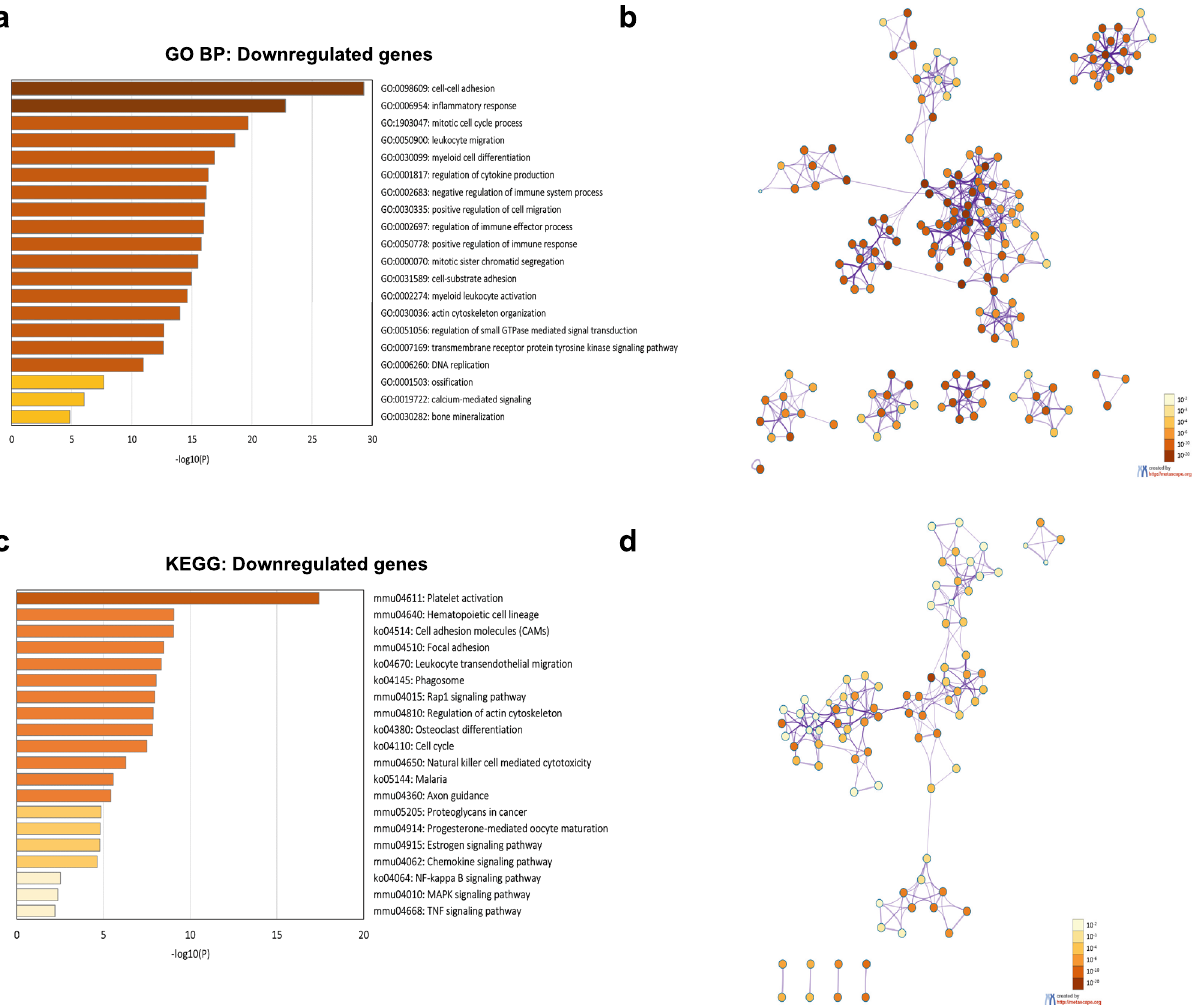
Figure 4. Enrichment analysis of the downregulated genes in FcγRIIB -/- mice was performed using Metascape. ( a ) Bar graph showing top 20 enrichment clusters of GO terms. ( b ) The network of enriched GO biological processes (colored by p -values) ( c ) Bar graph showing top 20 enrichment clusters of KEGG pathways. ( d ) The network of enriched KEGG pathways (colored by p -values). The enriched GO biological processes and KEGG pathways were ranked by -log10 p -value of gene